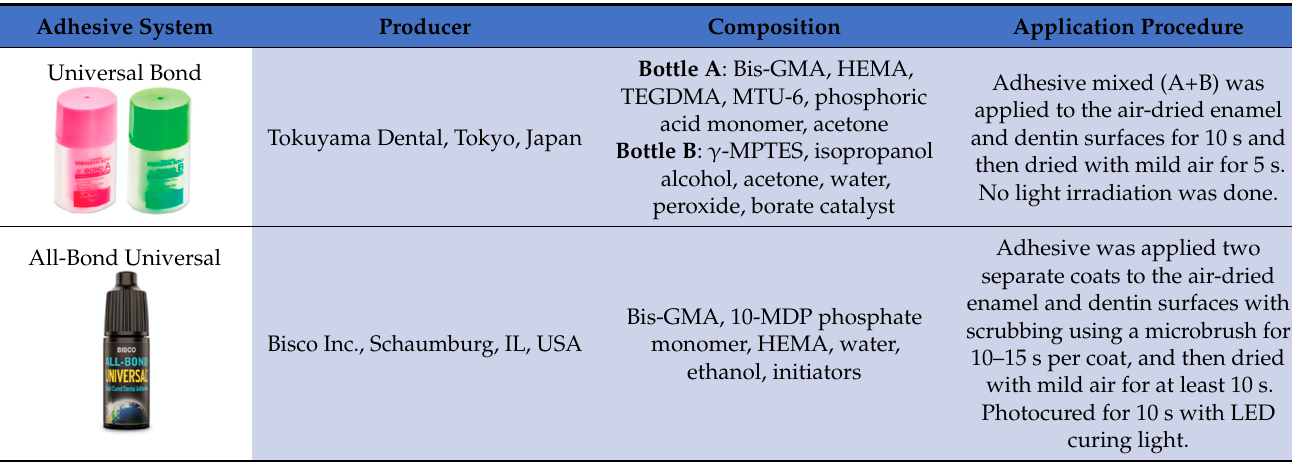
Table 1. Composition and application of the two universal adhesives systems used.